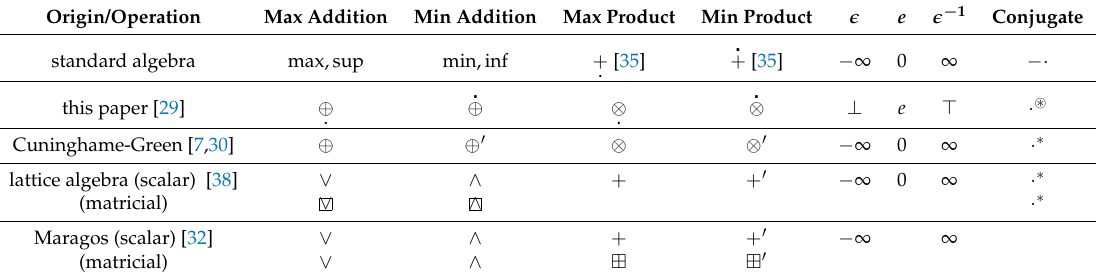
Table A1. Different notations used for the completed max-min-plus semifield in the